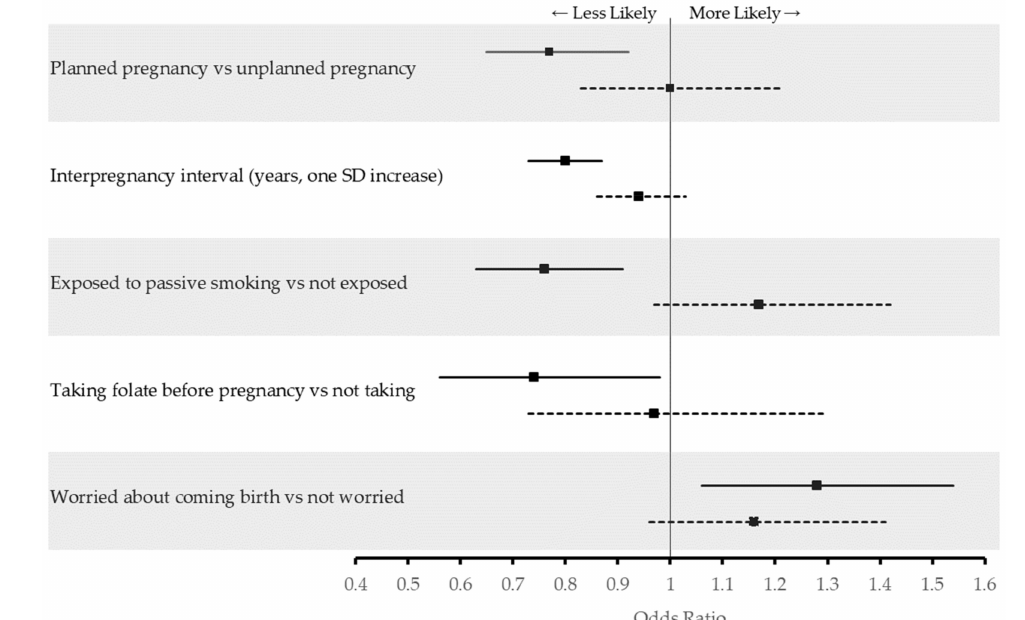
Figure 2. Adjusted odds ratios of activities and behaviors during * current pregnancy associated with time since first diagnosis of previous GDM amongst 5738 pregnant women in Al Ain, UAE. The Mutaba’ah Study. Solid lines indicate adjusted odds ratios (aOR) and 95% confidence interval (CI) among women with a history of previous GDM who had ≤ 5 years since their first diagnosis while dotted lines indicate aOR and 95% CI among women with a history of previous GDM who had >5 years since their first diagnosis compared to women with no history of previous GDM. * Folate consumption before current